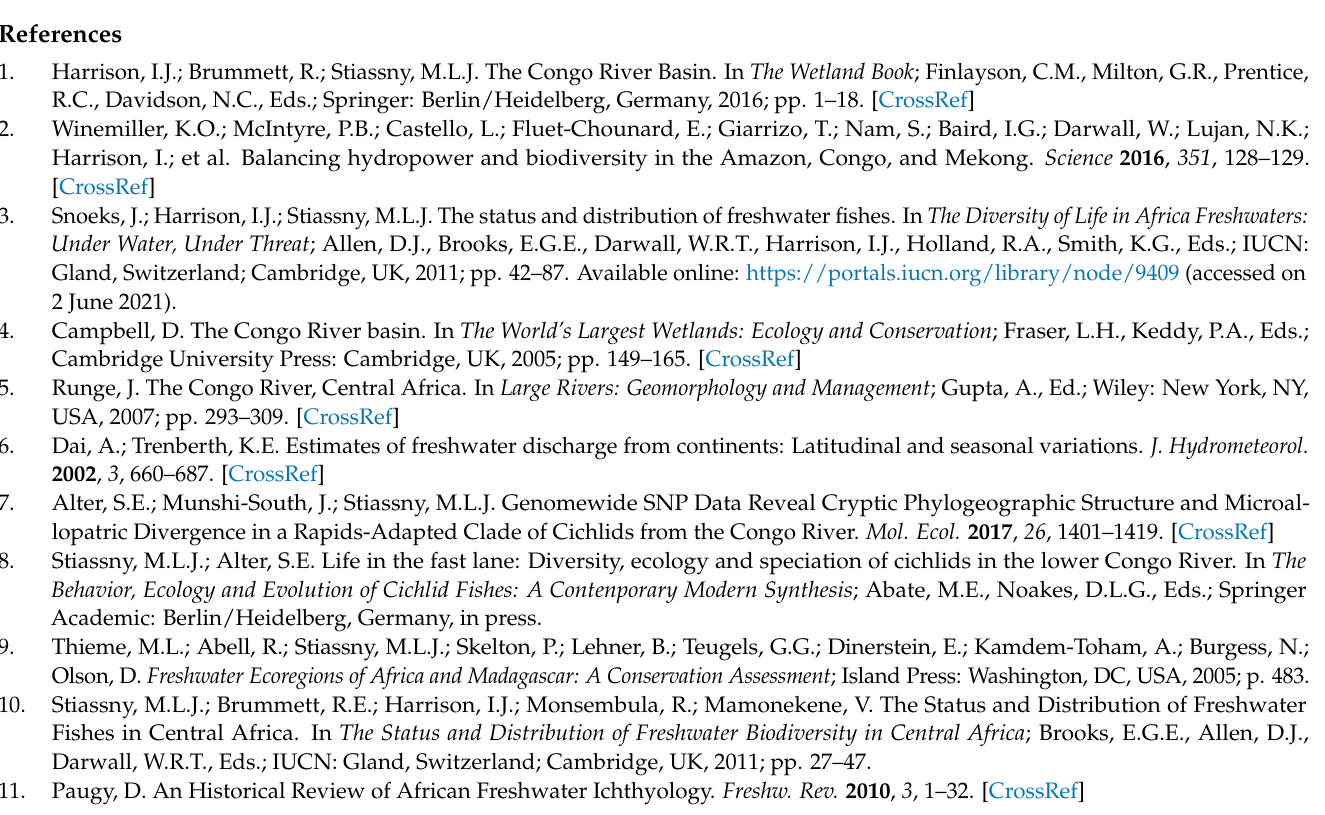
Figure A8. Map of the lower Lulua River showing locations of selected anthropogenic activities in the sampling area.